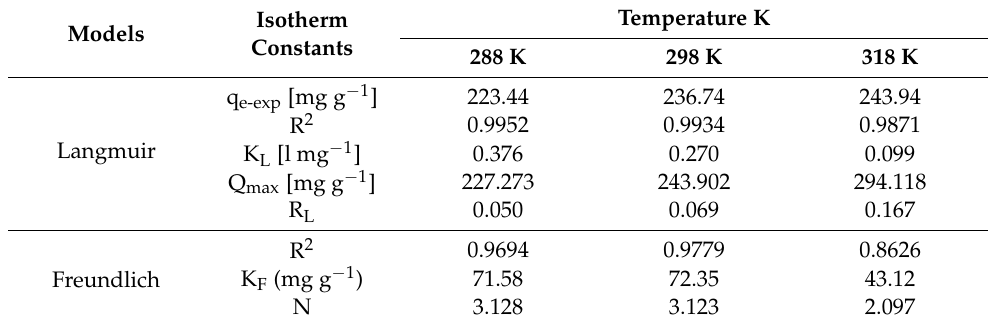
Table 3. Langmuir and Freundlich constants for Az adsorption onto Ni/Zn LDH nanohybrid.